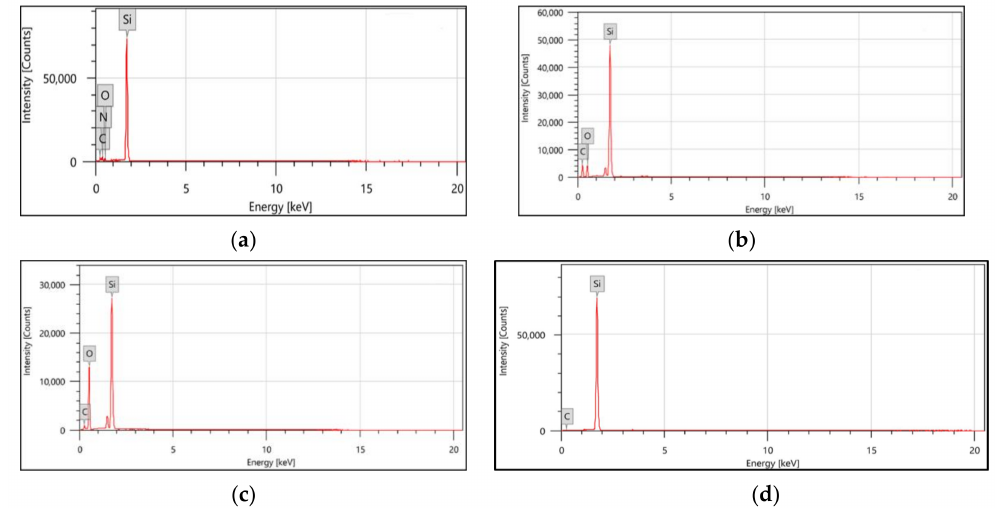
Figure 6. Chemical composition of the monocrystalline photovoltaic cell surface ( a ) without laser modification, ( b ) the point on the surface of the cutting line, ( c ) the point on the surface of the cell next to the cutting edge, and ( d ) the point on the surface of the